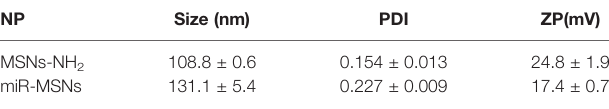
TABLE 1 | Characterization of the prepared